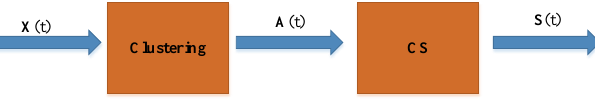
Figure 9. Schematic diagram of two-step method for